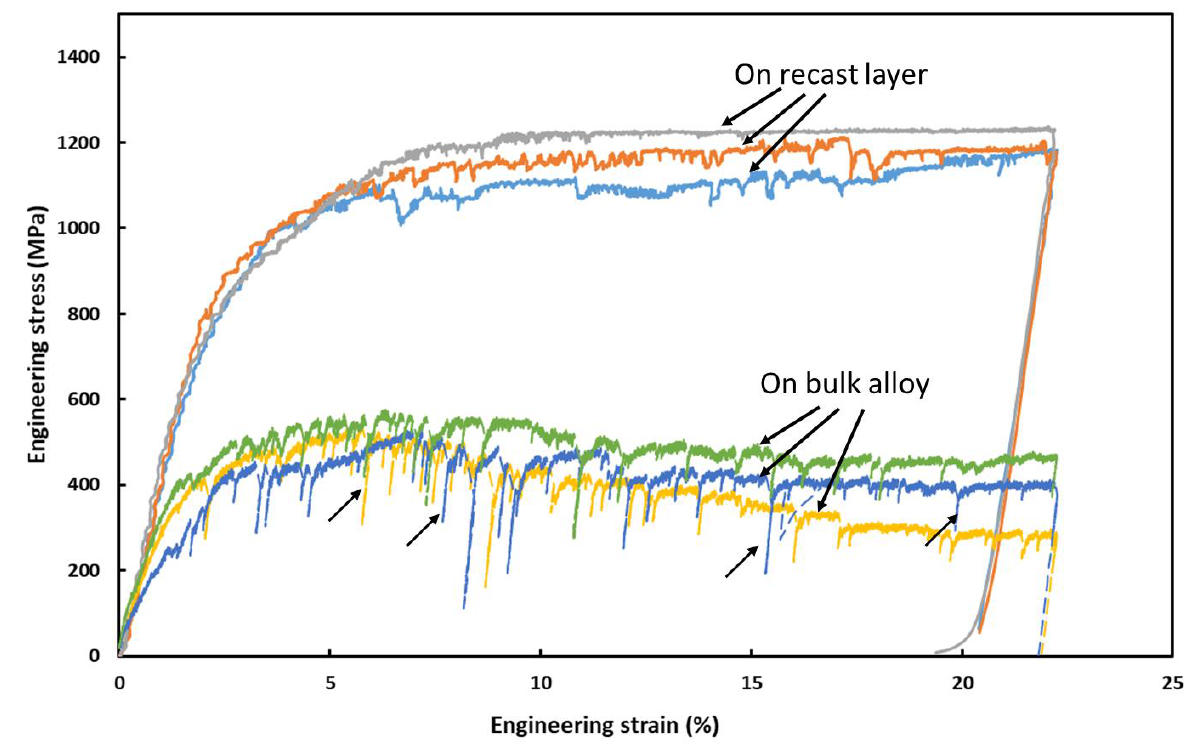
Figure 6. Representative stress – strain curves on recast layer and bulk Inconel 718 alloy derived from load-displacement curves under in-situ micro-pillar compression. Table 1. Micro-mechanical properties of the recast layer and bulk material.